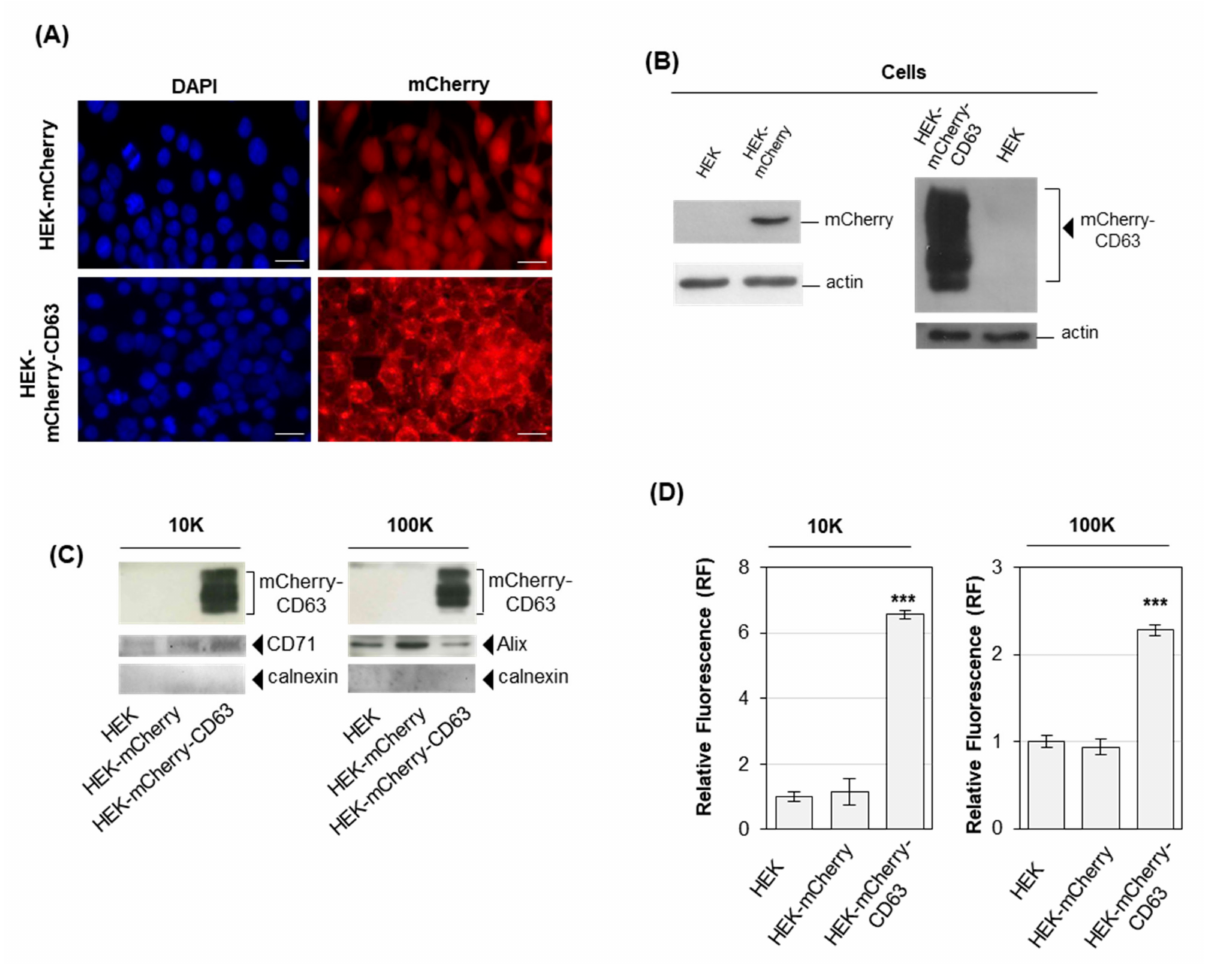
Figure 1. HEK cells expressing mCherry release fluorescent EVs . ( A ) Fluorescence microscopy. HEK cells were either transfected with mCherry or with mCherry-CD63 and selected with blasticidin-S. Cells were grown onto glass coverslips, fixed with 4% paraformaldehyde and stained for nuclei with DAPI. Magnification 20 × . Scale bar 20 µ m. ( B ) Immunoblotting analysis of mCherry in cells. Extracts were sized by SDS-PAGE and probed with an anti-mCherry antibody. As internal control, the membrane was also probed with an antiactin antibody. ( C ) Immunoblotting analysis of mCherry in EVs. Vesicles were obtained by centrifugation at 10,000 × g (10K fraction) or 100,000 × g (100K fraction). Extracts were sized by SDS-PAGE and probed with the indicated antibody. ( D ) Fluorescence analysis of EVs. 10K and 100K fraction pellets from the culture medium of 107 cells were resuspended in 100 µ L PBS and assayed for fluorescence at 580 nm ex, 620 nm em. *** p < 0.001 with respect to untransfected HEK cells as